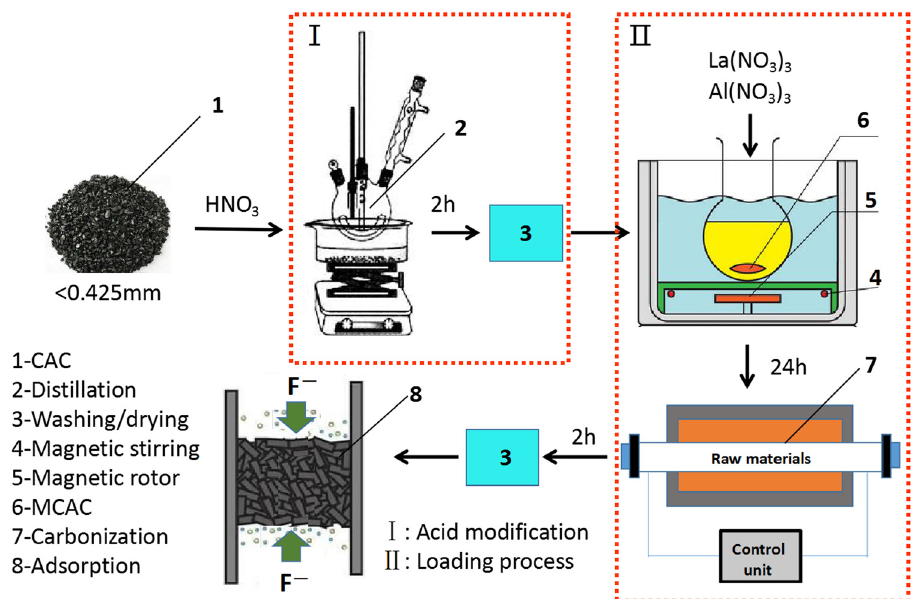
Figure 1: Illustration of preparation and adsorption